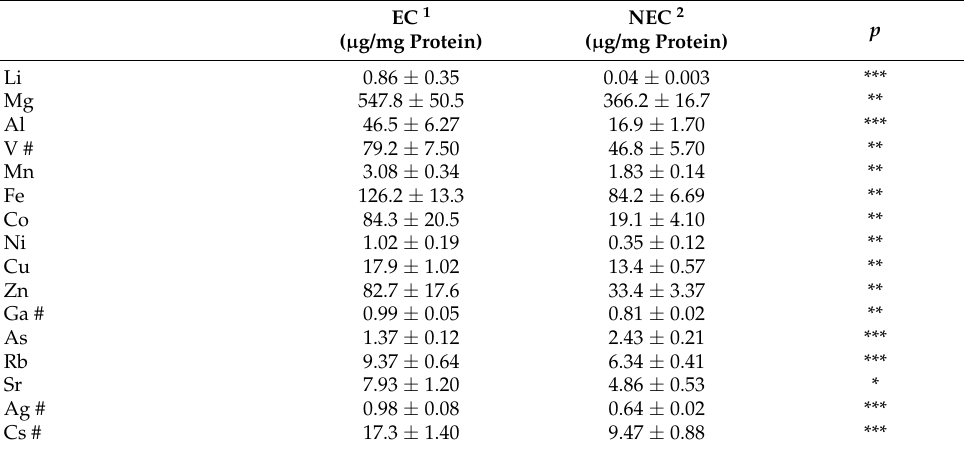
Table 2. Plasma metal and metalloid levels in subjects with good renal outcomes between CKDu endemic 1 and nonendemic 2 areas.